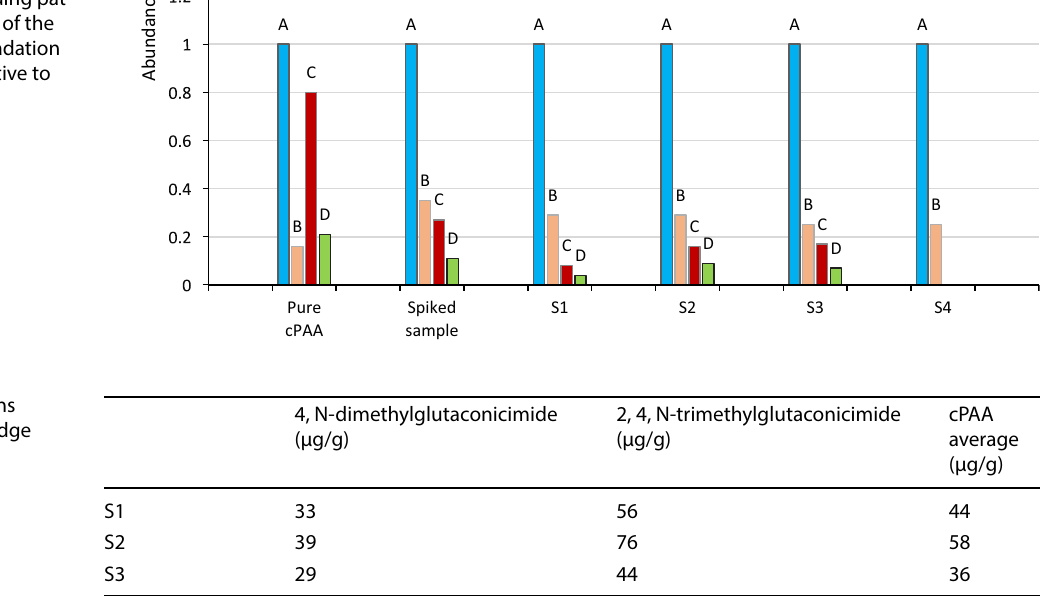
Fig. 5 The corresponding pat- tern by peak integrals of the specific thermal degradation products of cPAA relative to compound A